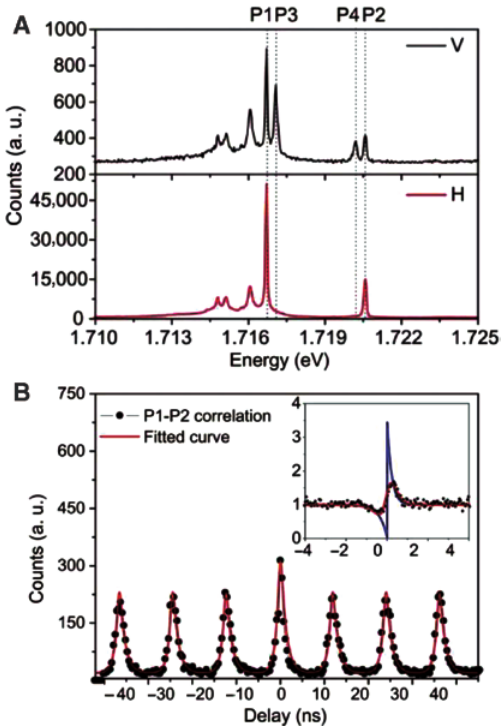
Figure 16: Cascaded emission for quantum emitters in monolayer WSe . 2 (A) Low-temperature PL spectra of a selected narrow line emitting center hosted by a WSe monolayer, resolved into two orthogonal 2 linear polarizations V and H. Marked with dashed lines are two doublets of narrow emission features (P1, P3) and (P2, P4) associ- ated with the cascaded recombination of a biexciton and exciton, respectively. (B) Photon cross-correlation histogram obtained for the pair of lines (P1, P2) under both pulsed (main graph) and continuous-wave (inset) excitation. Figure reprinted with permission from Ref. [122].